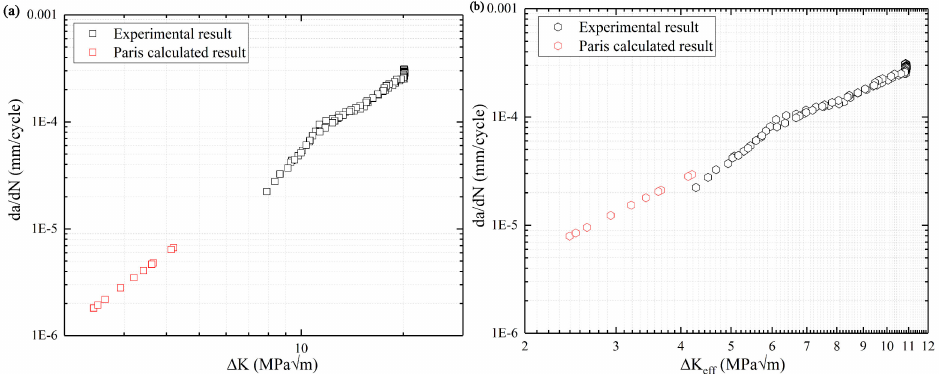
Figure 16. The calculated value of da / dN corresponding to the ∆ K B of R = 0.1. ( a ): K max − K min and ( b ): K max − K OP